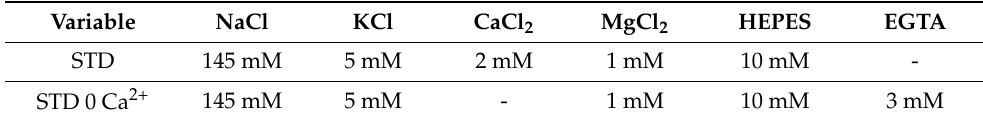
Table 1. Composition of extracellular solutions (pH 7.3, adjusted with NaOH, and 300 mOsm/kg H 2